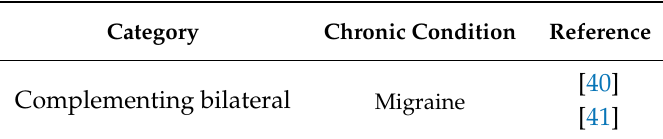
Table 8. Complementing bilateral chosen